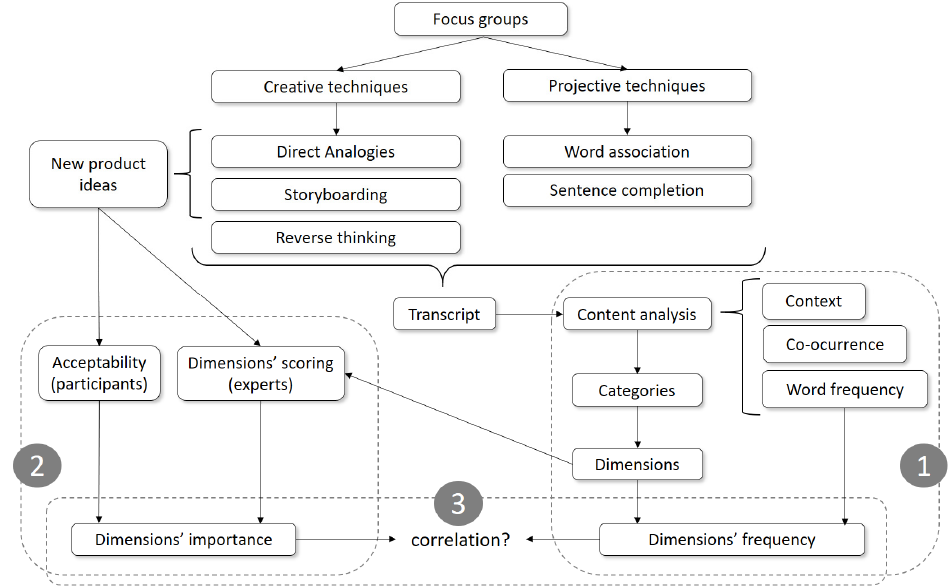
Figure 1. Outline of the main steps taken during data analysis of the focus groups: ( 1 ) dimensions’ identification and their frequencies; ( 2 ) dimensions’ importance; and ( 3 ) dimensions’ importance versus dimensions’ frequency.